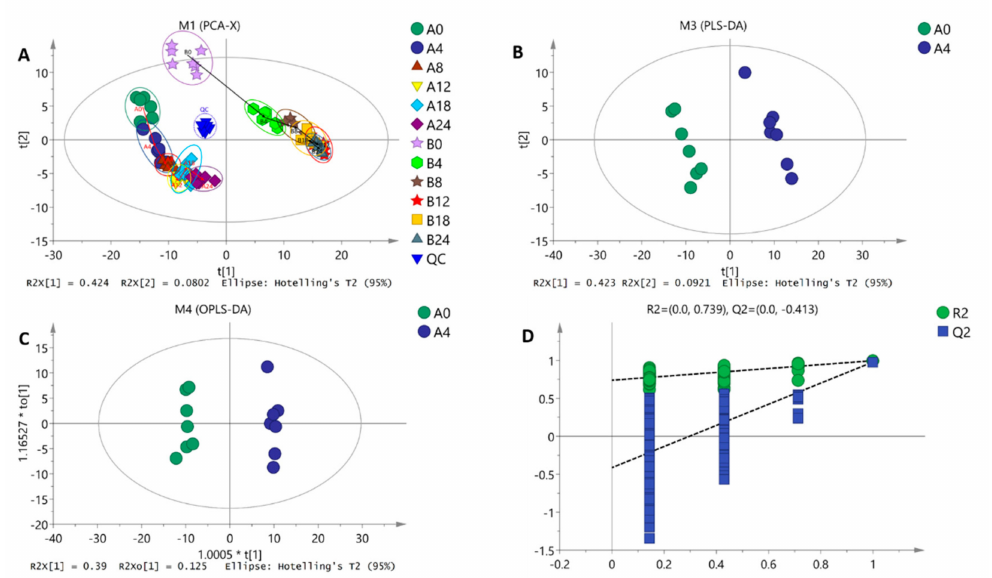
Figure 4. SIMCA software (V14) was used to perform multivariate variable pattern recognition for the normalized data. ( A ) Principal component analysis score plot of two strains treated at di ff erent times and quality control samples. ( B , C ) Score plot of partial least square discriminant analysis (PLS-DA) and orthogonal partial least square discriminant analysis (OPLS-DA) derived from the GC–MS profiles of serum samples obtained from the heat stress (4 h) group versus the normal control (0 h) group. ( D ) Response ordering test for the OPLS-DA model. ( B – D ) show strain 18 at 4 h versus 0 h as an example, and others are shown in Supplementary